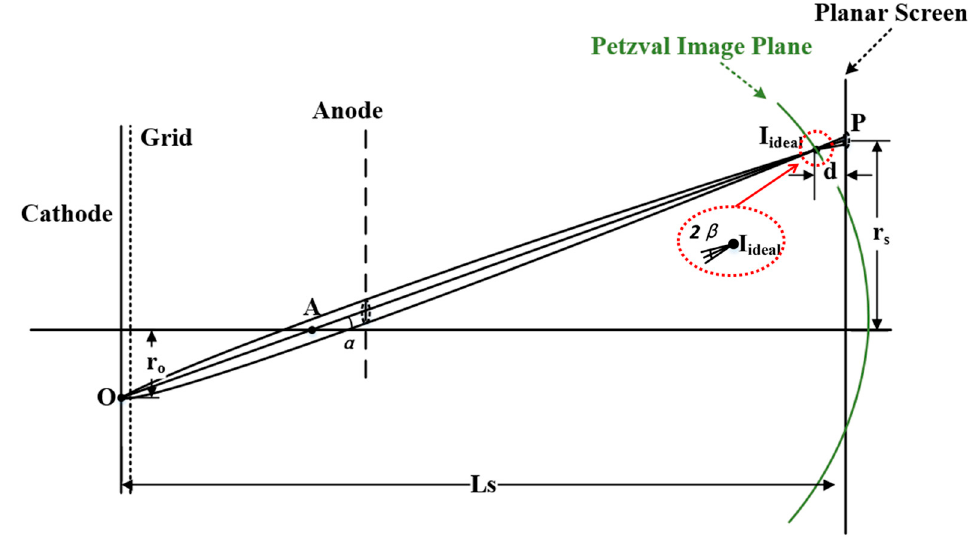
Figure 1. Shape and position of electron beam image plane.